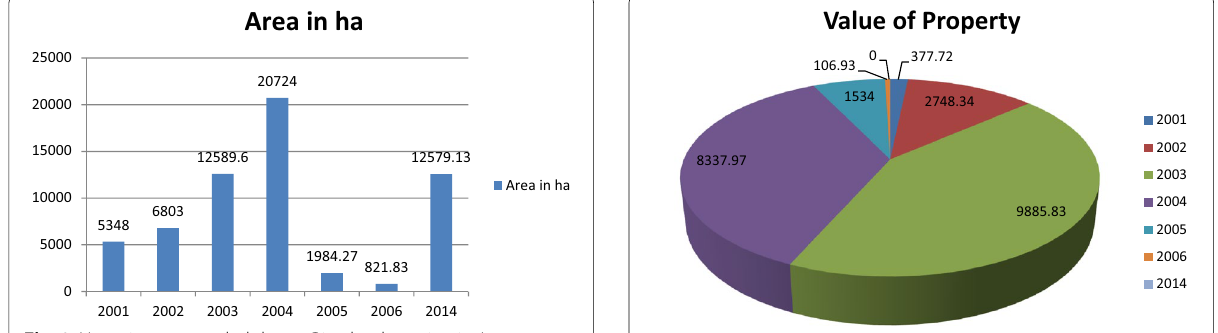
Fig. 5 Year-wise loss of property (Rs. in Crore) in Assam due to flood and erosion. Source: Water Resource Department,